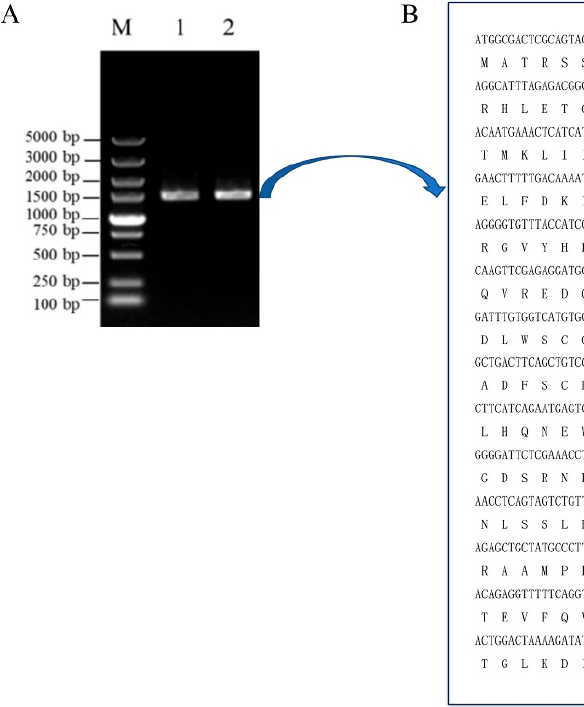
Figure 1. Cloning of the CDS sequence of GhCIPK23 gene in upland cotton. ( A ) Agarose gel electrophoretic analysis of PCR amplification product of GhCIPK23 gene; 1 and 2: Target gene; M: DNA marker (DL5000). ( B ) The CDS sequence of GhCIPK23 and its encoded protein by sequencing. the red base represents the stop codon.